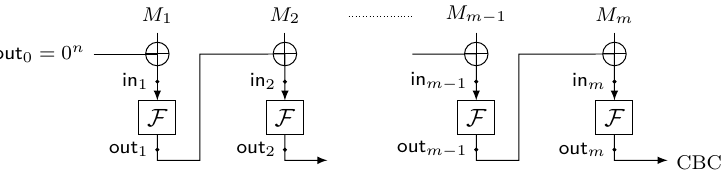
Figure 1: CBC function and its intermediate values where f ∈ Func